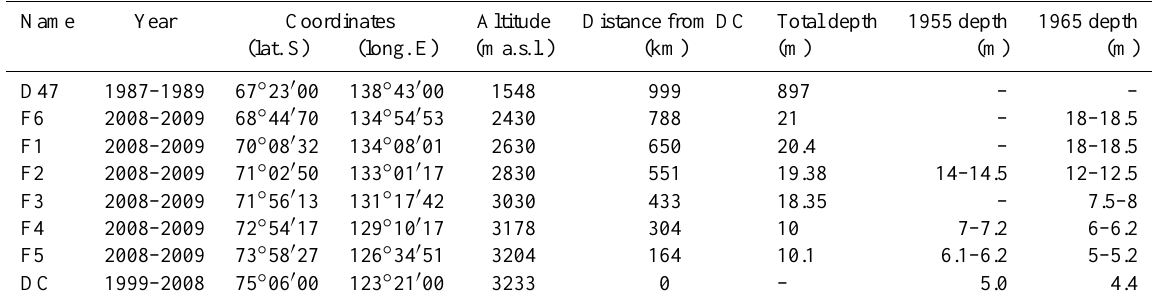
Table 2. Firn and ice cores used in this study: name, drilling year, coordinates, altitude in m above sea level (a.s.l.), distance from DC station, total drilling depth, depth of 1955 and 1965 radioactive layers in 2009. DC data is a compilation of different datasets. The 1955 and 1965 depths at DC are based on the 2004 EPICA Dome C core depths. Corresponding depths in 2009 were estimated using stake measurements from GLACIOCLIM-SAMBA observatory, as explained in Sect.